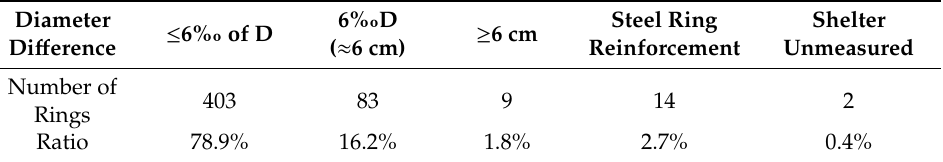
Table 3. Statistical table of horizontal diameter di ff erences.